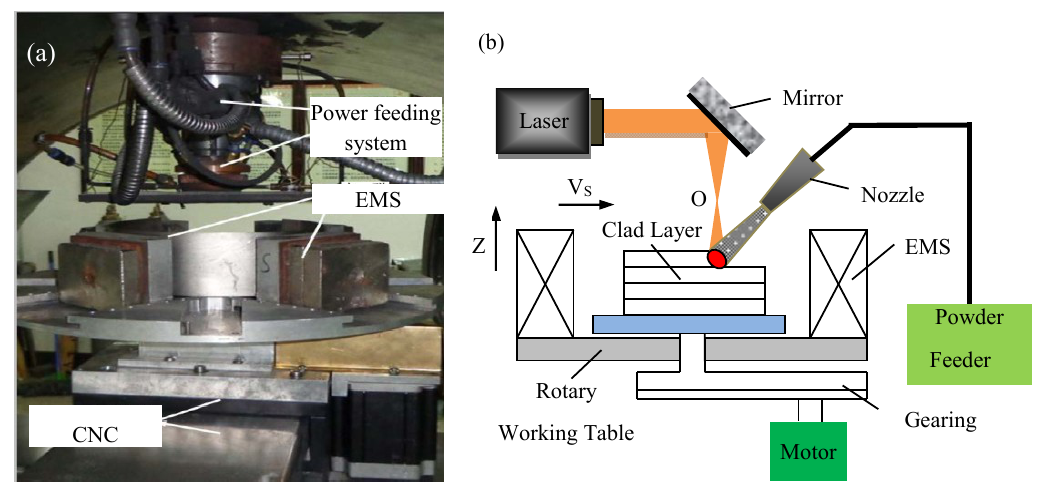
Figure 1. The equipment for laser solid forming (LSF) with electromagnetic stirring: ( a ) picture; ( b ) schematic diagram.